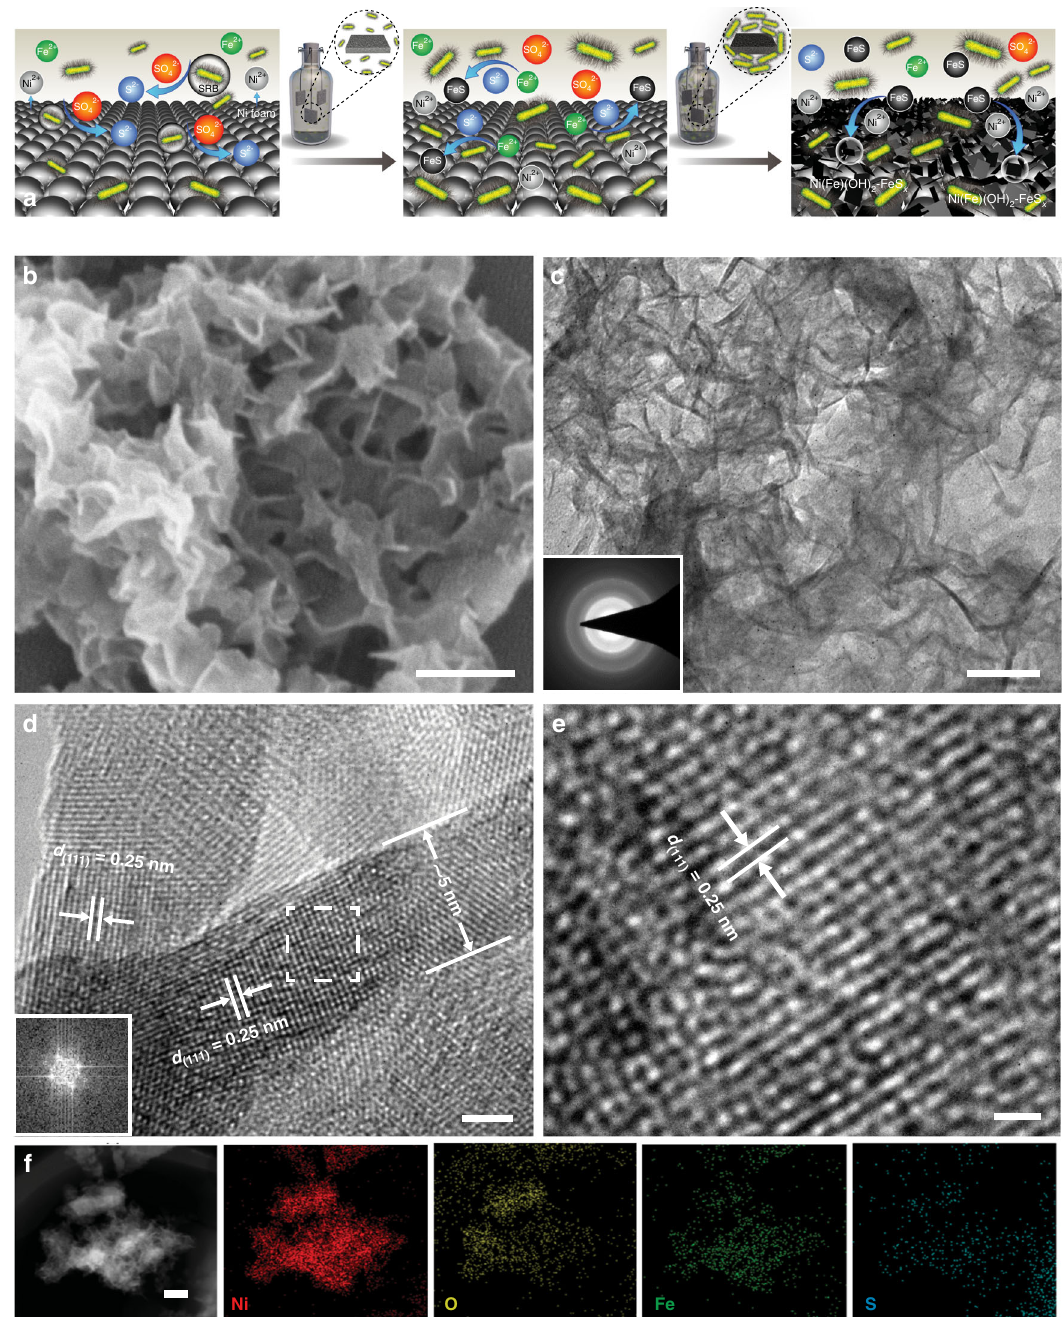
Fig. 1 Formation and structural characterizations of Ni(Fe)(OH) 2 – FeS x . a Preparation scheme of the SRB-assisted corrosion-formed electrode. b FESEM image, scale bar: 200 nm. c TEM image and corresponding SAED pattern (inset), scale bar: 50 nm. d , e HRTEM images and corresponding fast Fourier transform (FFT) pattern (inset in d ), scale bars: 2 nm ( d ) and 1 nm ( e ). f corresponding elemental mappings, scale bar: 250